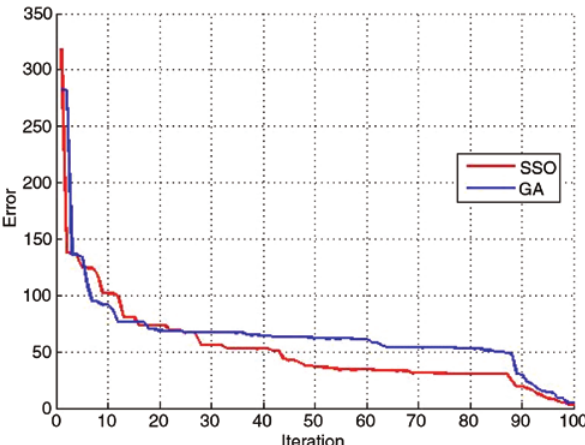
Figure 1: Convergence